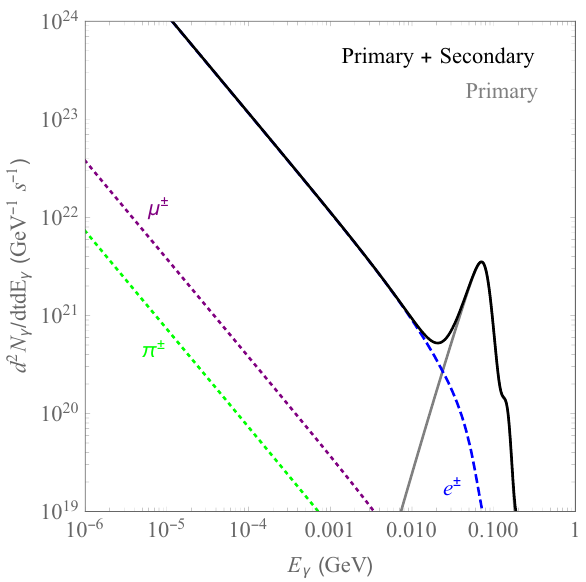
Figure 7 . Photon spectrum for a Schwarzschild PBH with M = 5 × 10 11 kg, obtained using the semi-analytical method (black), illustrating the different contributions including primary photons (gray) and secondary photons from electron (blue), muon (purple) and pion (green)